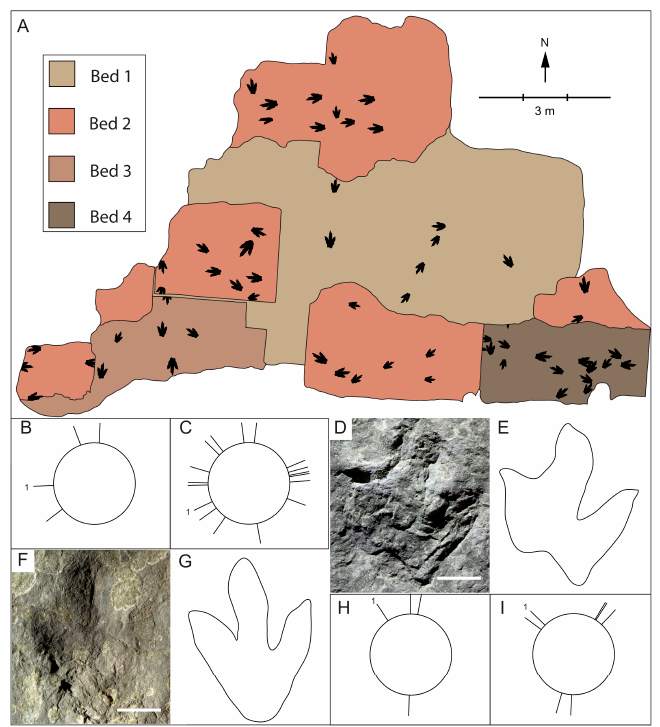
Figure 4. Eubrontes giganteus tracks, trackways, and orientations from Powder Hill Dinosaur Park in Middlefield, Connecticut. ( A ) Sketch map of the quarry floor showing all track-bearing beds; ( B ) Rose diagram of track and trackway orientations on Bed 1; ( C ) Rose diagram track and trackway orientations on Bed 2; ( D , E ) photograph and interpretive drawing of E. giganteus inferred to be a true track; ( F , G ) photograph and line drawing, respectively, of a E. giganteus undertrack; ( H ) Rose diagram of track and trackway orientations on Bed 3; ( I ) Rose diagram of track and trackway orientations on Bed 4. Scale bars in ( D , F ) are 10 cm.